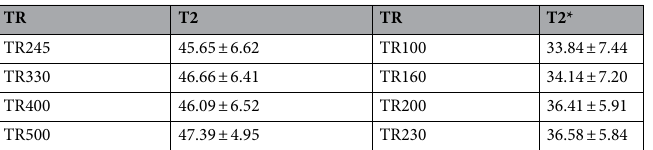
Table 6. Volunteers measurement of magnitude ± standard deviation of the ten volunteers using different TR values for both T2 and T2*